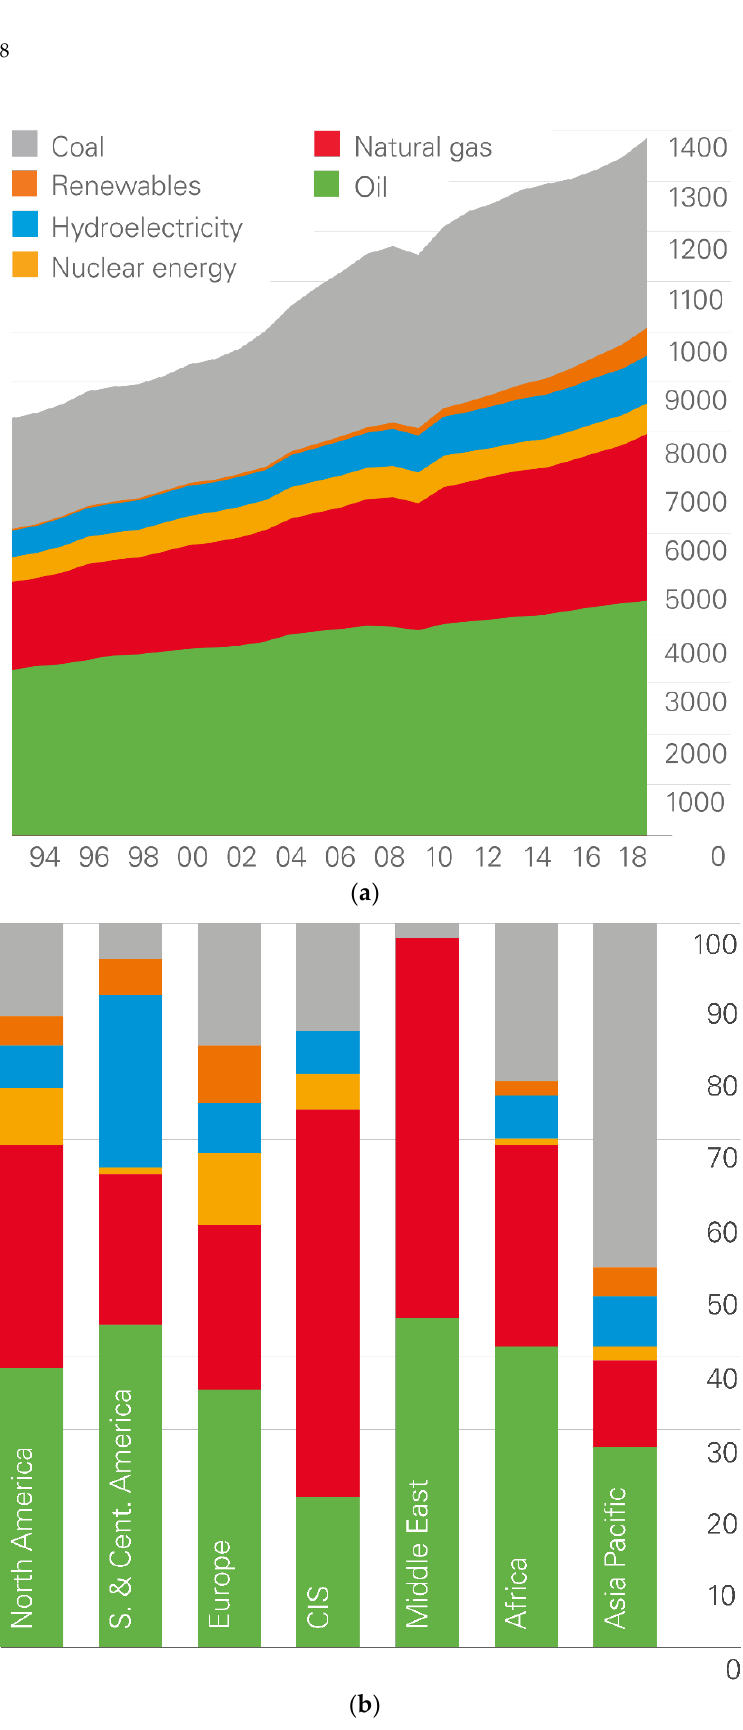
Figure 1. World Consumption by fuel from 1994 to 2018. ( a ) (million tones oil equivalent) and Regional Consumption by fuel 2018; ( b ) (% of different fuels, color legend in Figure 1a) [2].